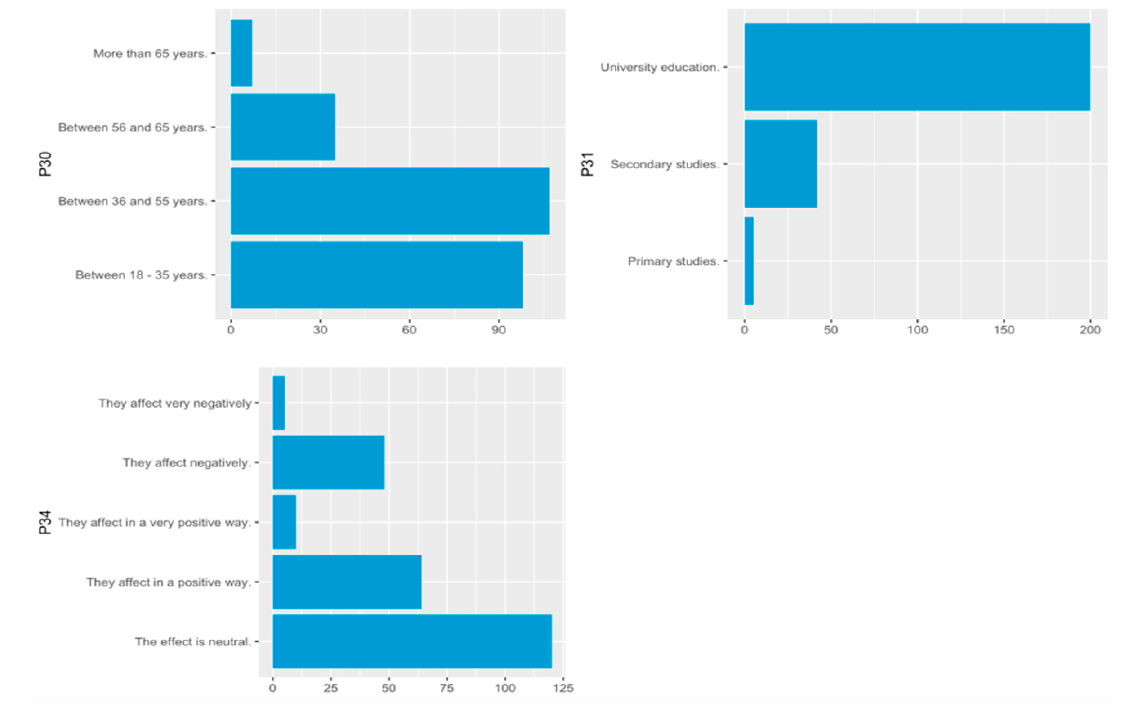
Figure 2. Summary of responses for age, education and opinion regarding the impact of tourism. Source: compiled by the authors.